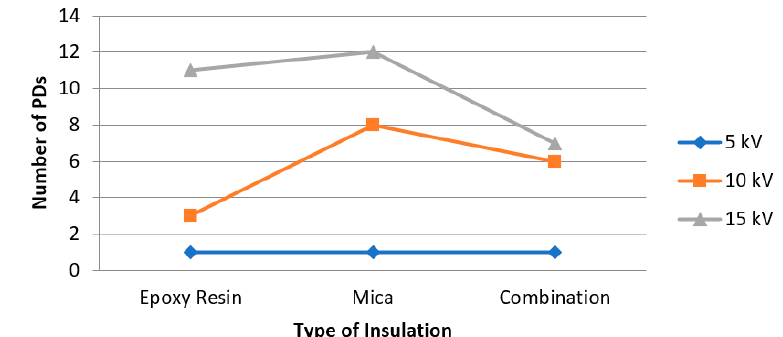
Figure 32. Number of PDs for the different insulation materials.